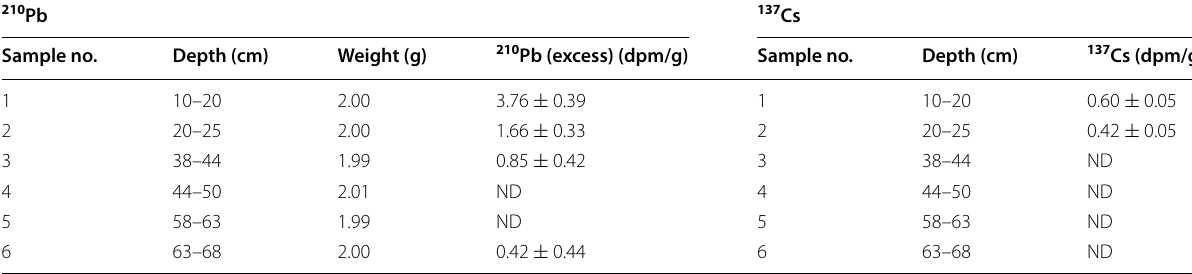
ND not detected